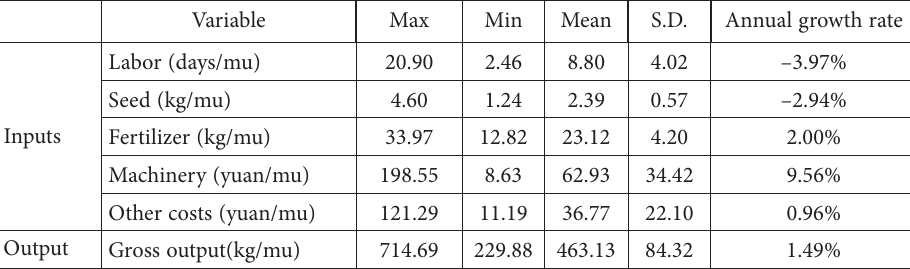
Table 1. Data description and annual growth rates of inputs and outputs over 2004–2017 Variable Max Min Mean